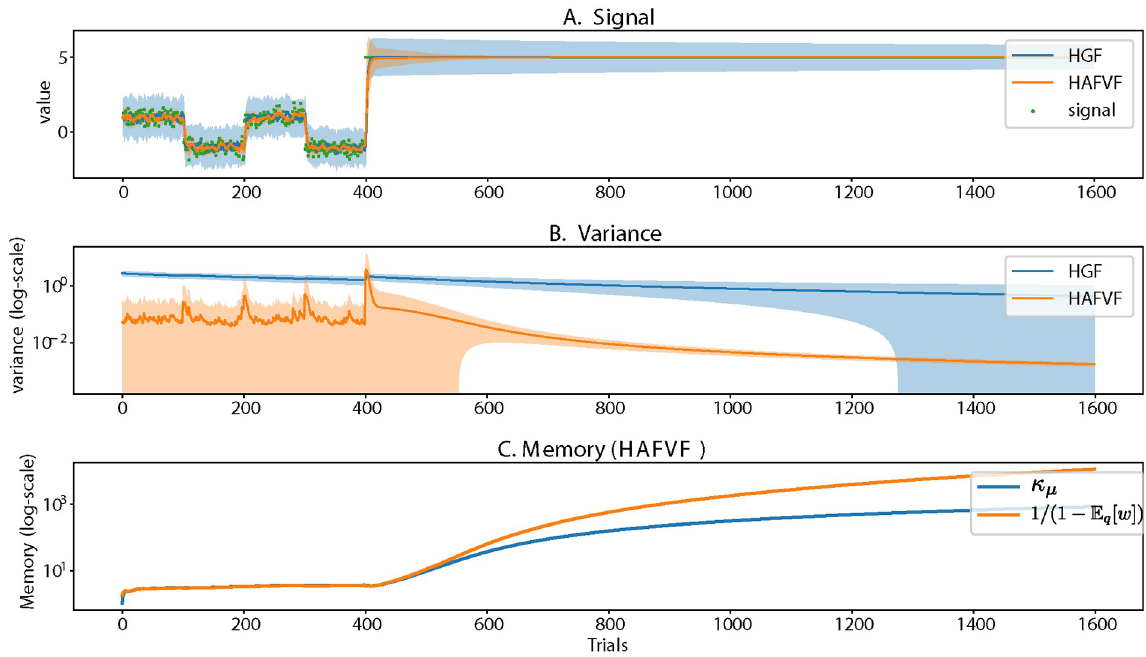
Fig 4. HAFVF and HGF performance on the same dataset. Shaded areas represent the ± 3 standard error interval. The two models were fitted to the first 400 trials, and then tested on the whole trace of observations. A . Observations, mean and standard error of the mean estimated by both models. B . The variance estimates show that the HAFVF adapted better to the variance in the first part of the experiment, reflected better the surprise at the contingency change and adapted successfully its estimate when the environment was highly stable. The HGF, on the contrary, rapidly degenerated its estimate of the variance, and did not show a significant trace of surprise when the contingency was altered. C . The value of the effective memory of the HAVFV is represented by the approximate posterior parameter κ μ , and the maximum memory (efficient memory, see Bayesian Q-Learning and the problem of flexibility) allowed by the model at each